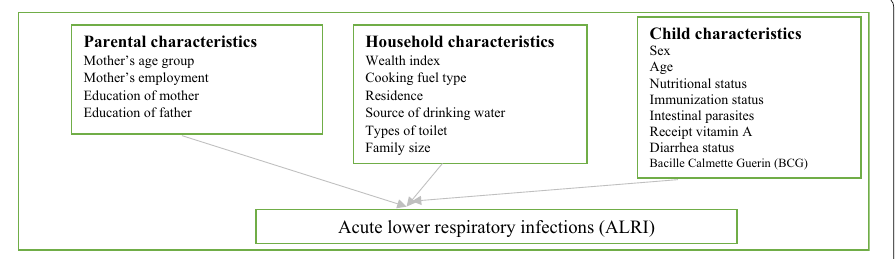
Fig. 2 Conceptual framework of risks factors for acute lower respiratory